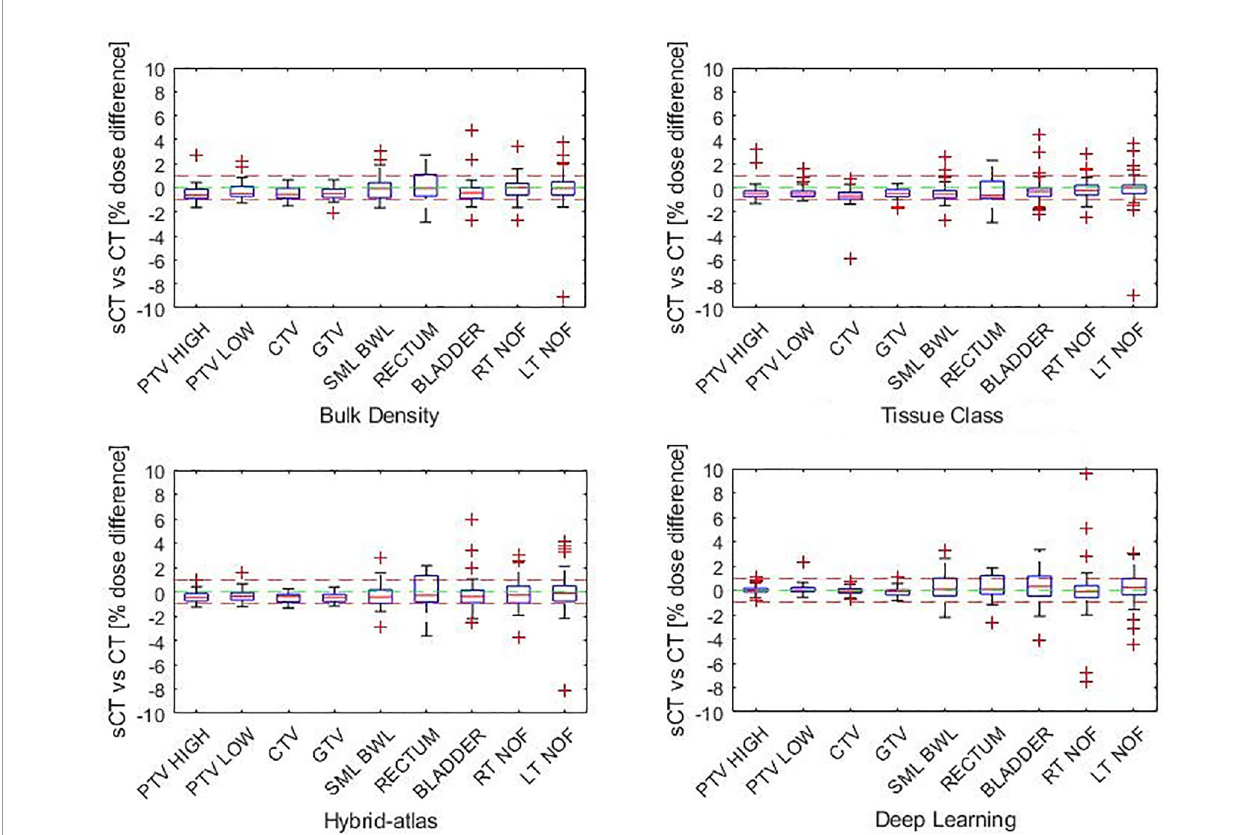
FIGURE 3 | Percentage DVH dose difference by structure (each structure parameter combined) for each synthetic CT